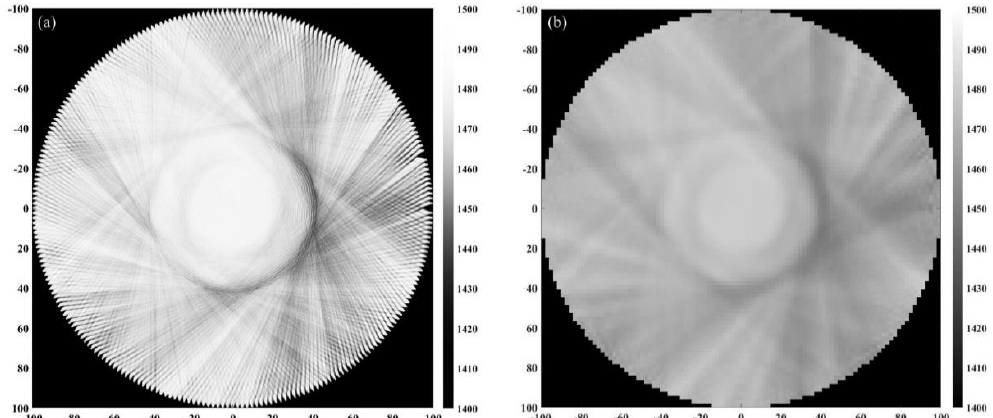
Figure 10. Experimental platform of breast ultrasound tomography system based on a CMUT ring array.